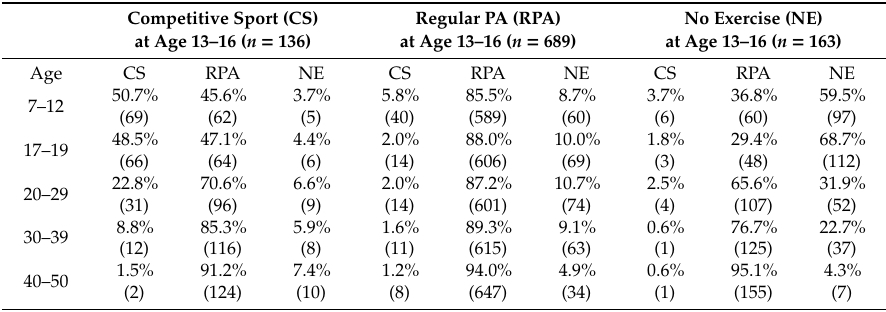
Table 1. Proportion ( n ) of participants of di ff erent physical activity (PA) level at each age stages according to the PA level at the age of